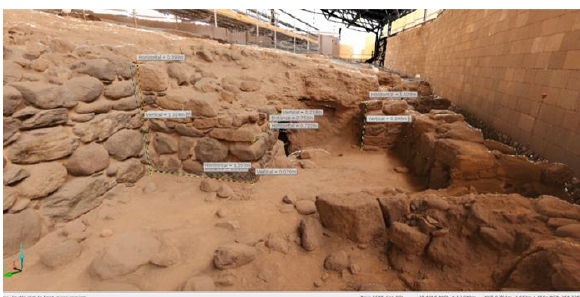
Figure 13. Example of the metric panorama corresponding to structure